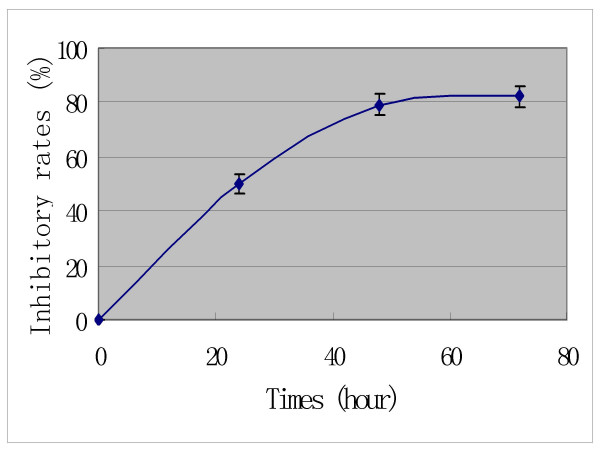
Time- response curve of probimane inhibiting a human gastric tumor cell line SCG-7901. MTT method was used. A: Pro concentration at 5 μM